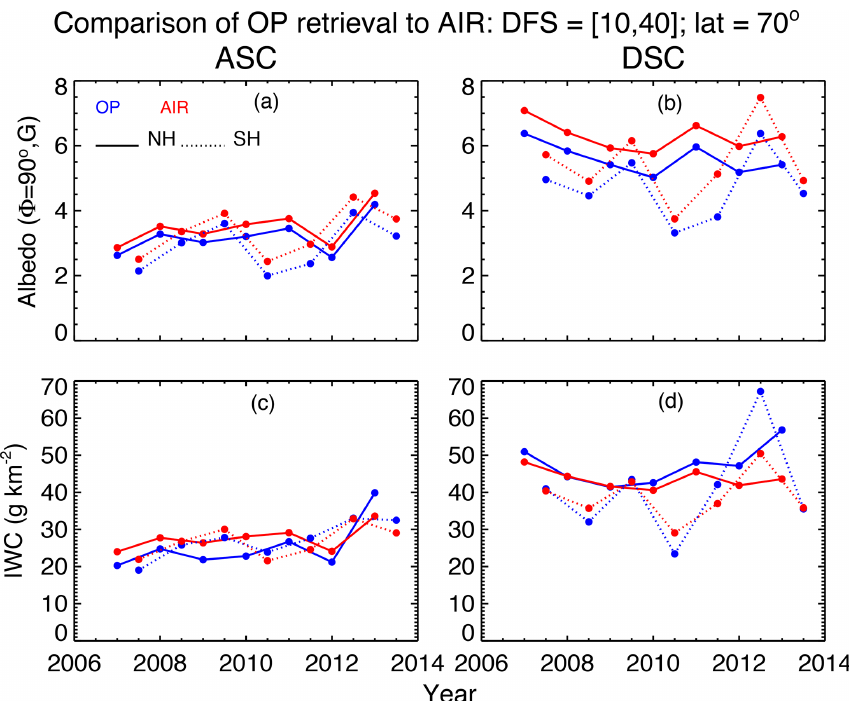
Figure 5. Comparison of CIPS A (90 ◦ ) (a, b) and (cid:104) IWC (cid:105) (c, d) calculated from the operational (OP) and AIR algorithms. Data points correspond to July Northern Hemisphere (NH) and January Southern Hemisphere (SH) averages in a 5 ◦ latitude bin centered at 70 ◦ . Panels (a, c) and (b, d) are for ascending (ASC) and descending (DSC) legs’ data, respectively.